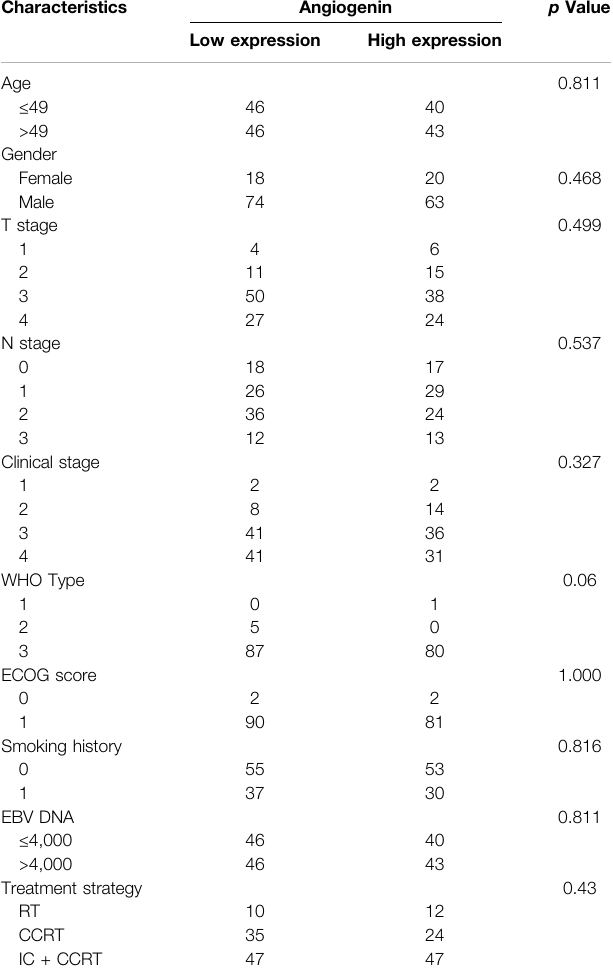
TABLE 1 | Characteristics of the NPC patients.; Abbreviation: CCRT, concurrent chemoradiotherapy; ECOG, Eastern Cooperative Oncology Group; IC, induction chemotherapy; NPC, nasopharyngeal carcinoma; RT, radiotherapy; WHO, World Health